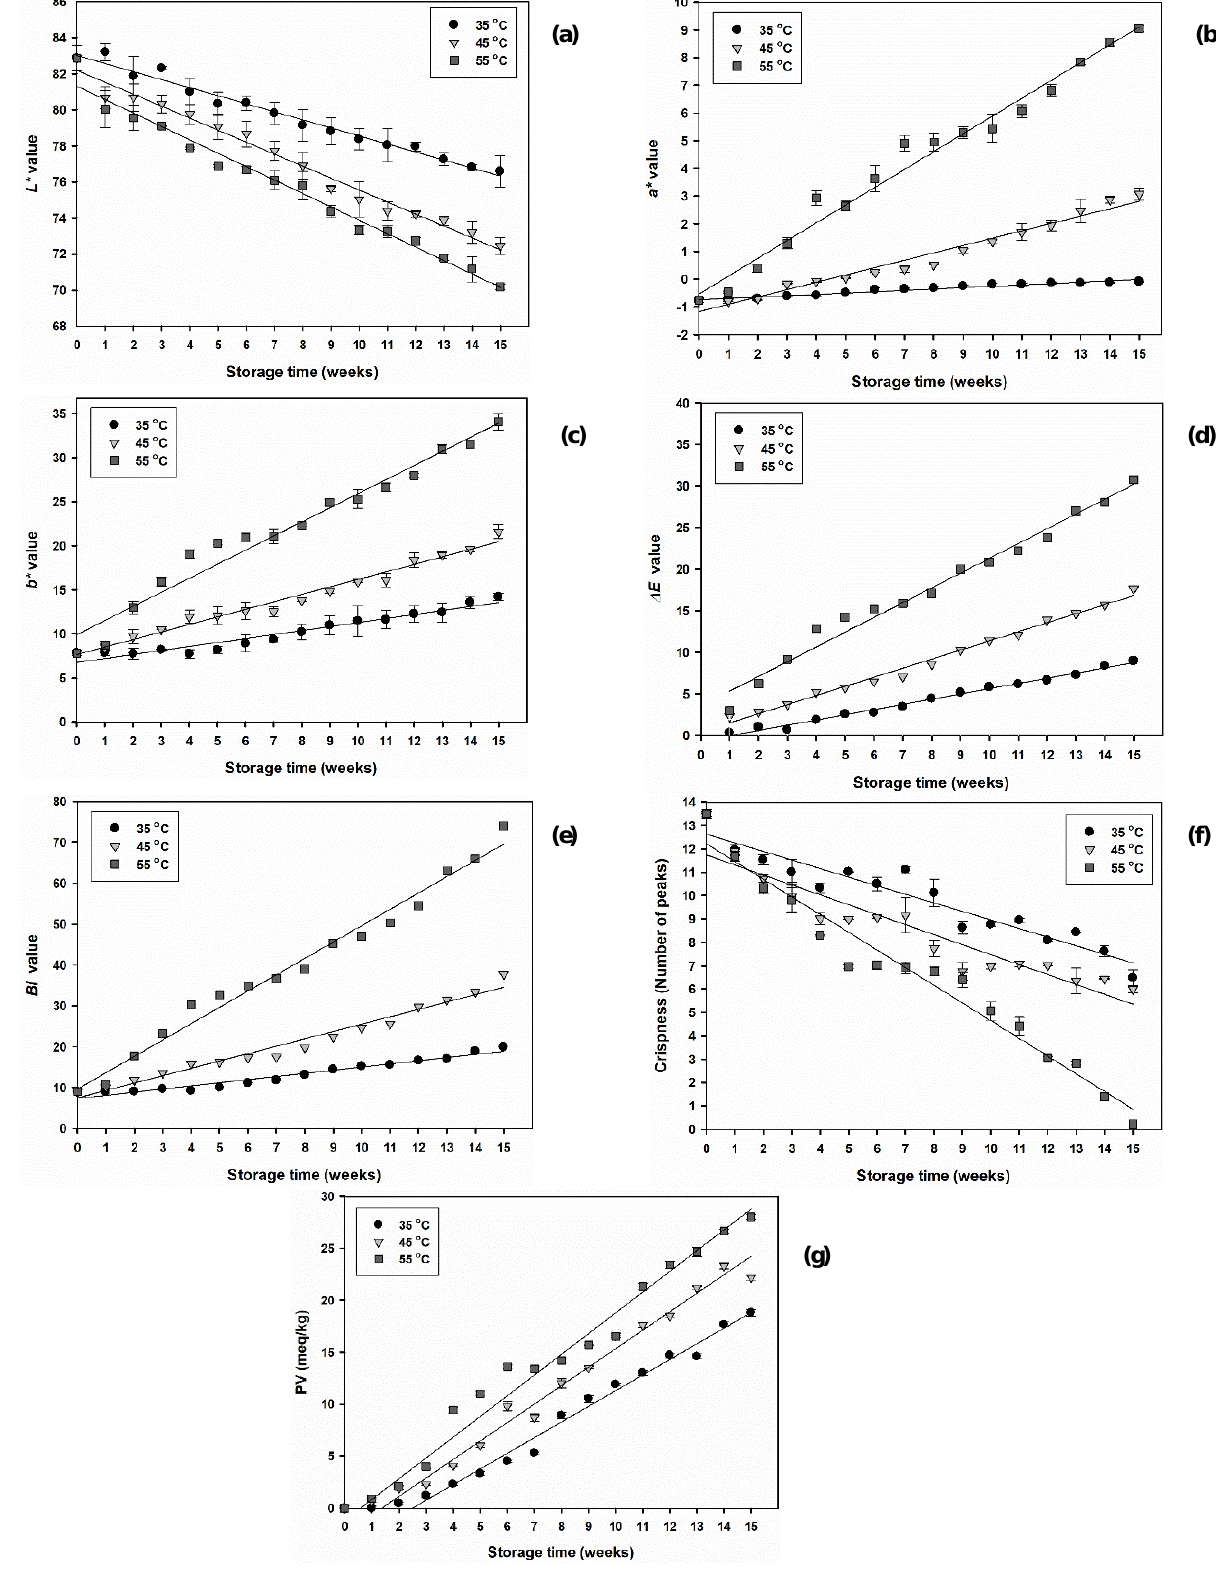
Figure 1. Quality change in dried coconut chips during storage at different temperatures for 15